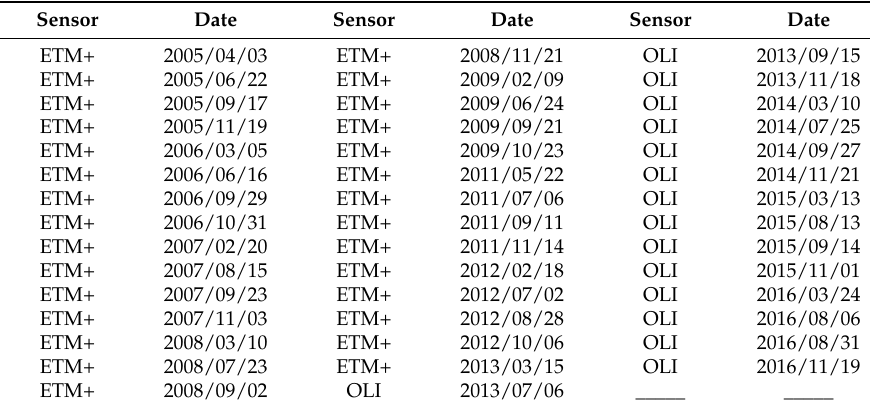
Table 1. The remote sensing data used in this